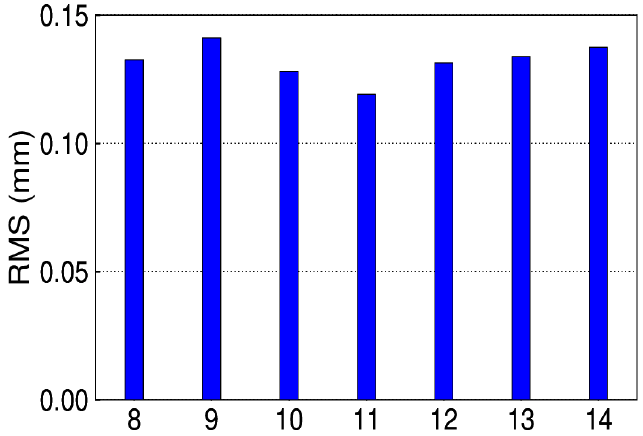
Figure 14. RMS for the IPs range from 8 to 14.